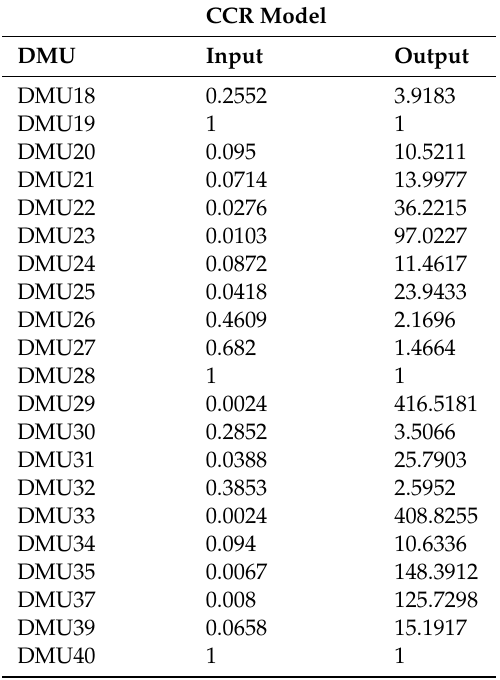
Table 3. CCR method for assessing the e ff ectiveness of food